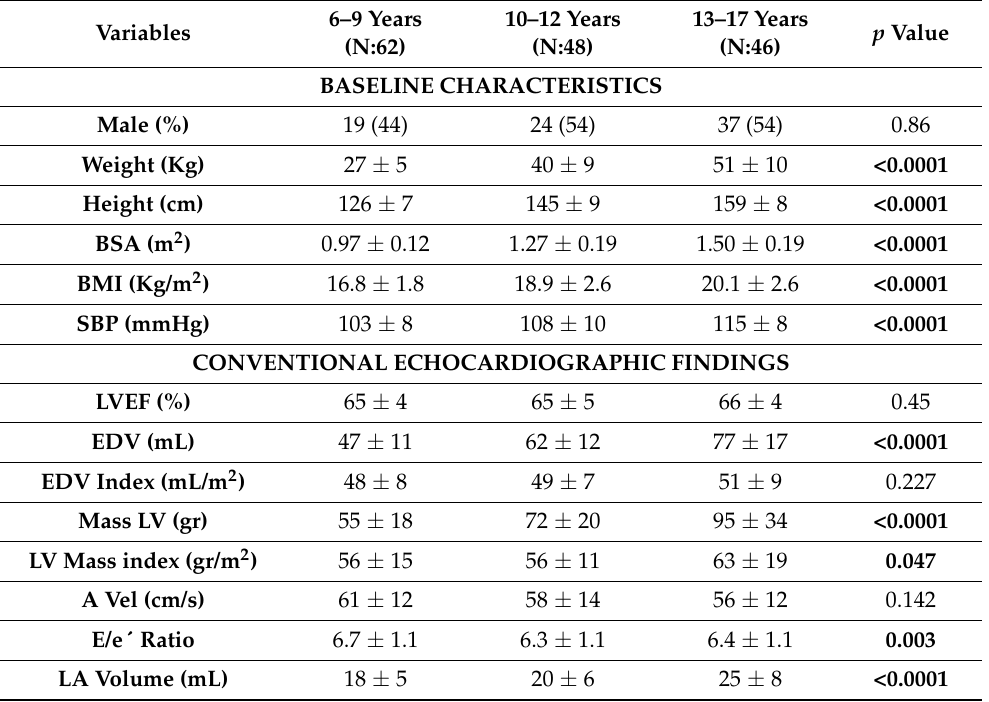
Table 2. The demographic, anthropometric and conventional echocardiographic parameters catego- rized by